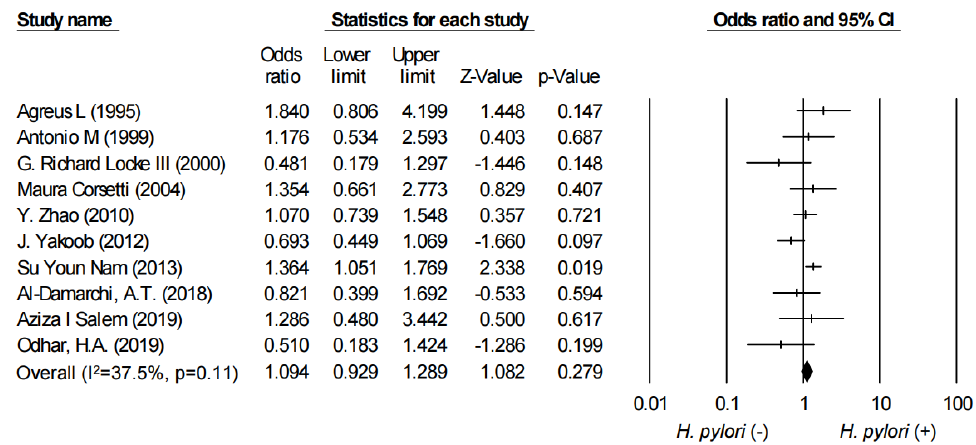
Figure 2. Forest plot evaluating the combined odds ratio (OR) between irritable bowel syndrome (IBS) and Helicobacter pylori infection.